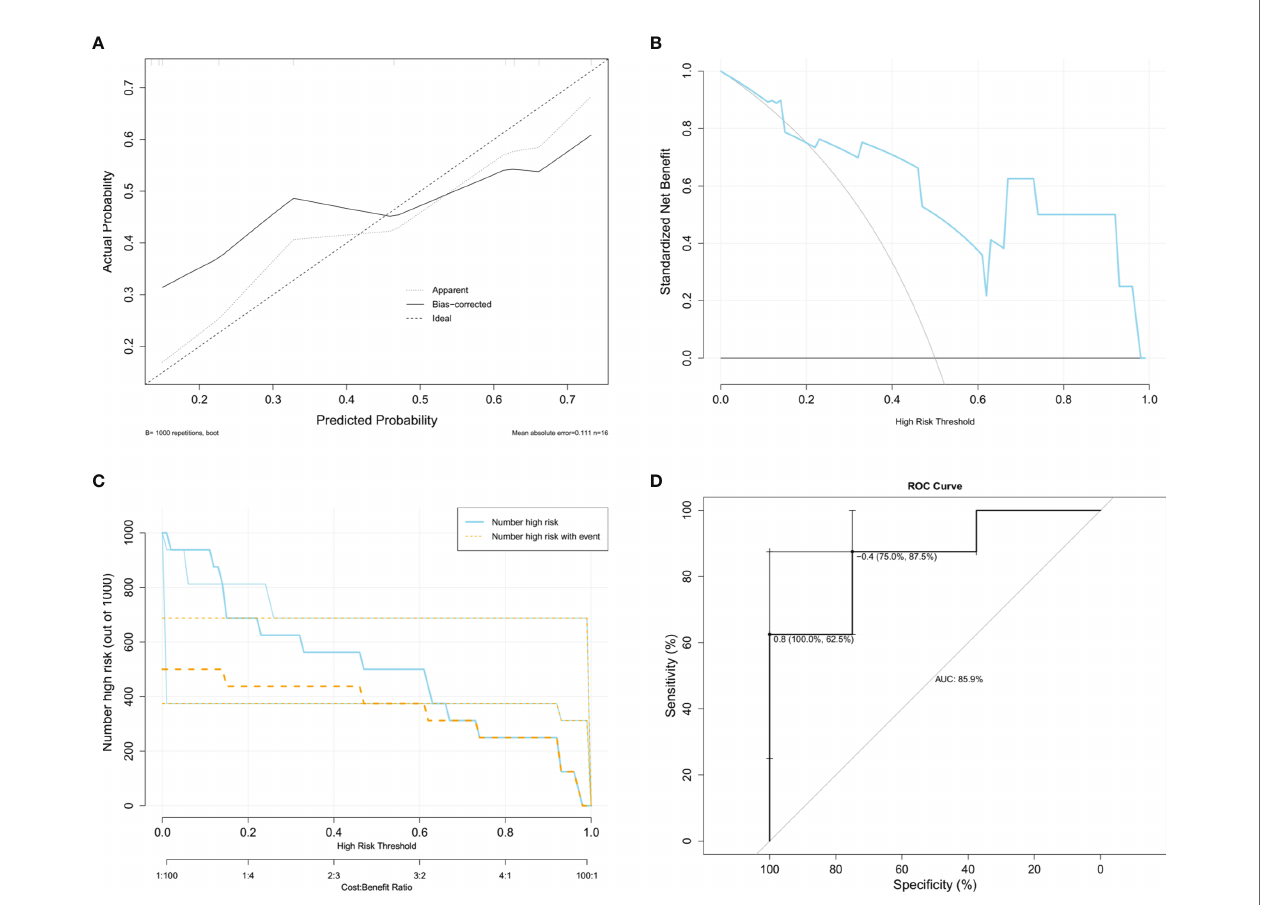
FIGURE 7 | Diagnostic value of the monocyte in fi ltration related DMRGs signature based on GSE92772. (A) Calibration curve to identify the diagnostic value for GDM. Decision curve (B) and clinical impact curve (C) for assessing the clinical usage. (D) ROC curve used for assessing the sensitivity and speci fi city of the